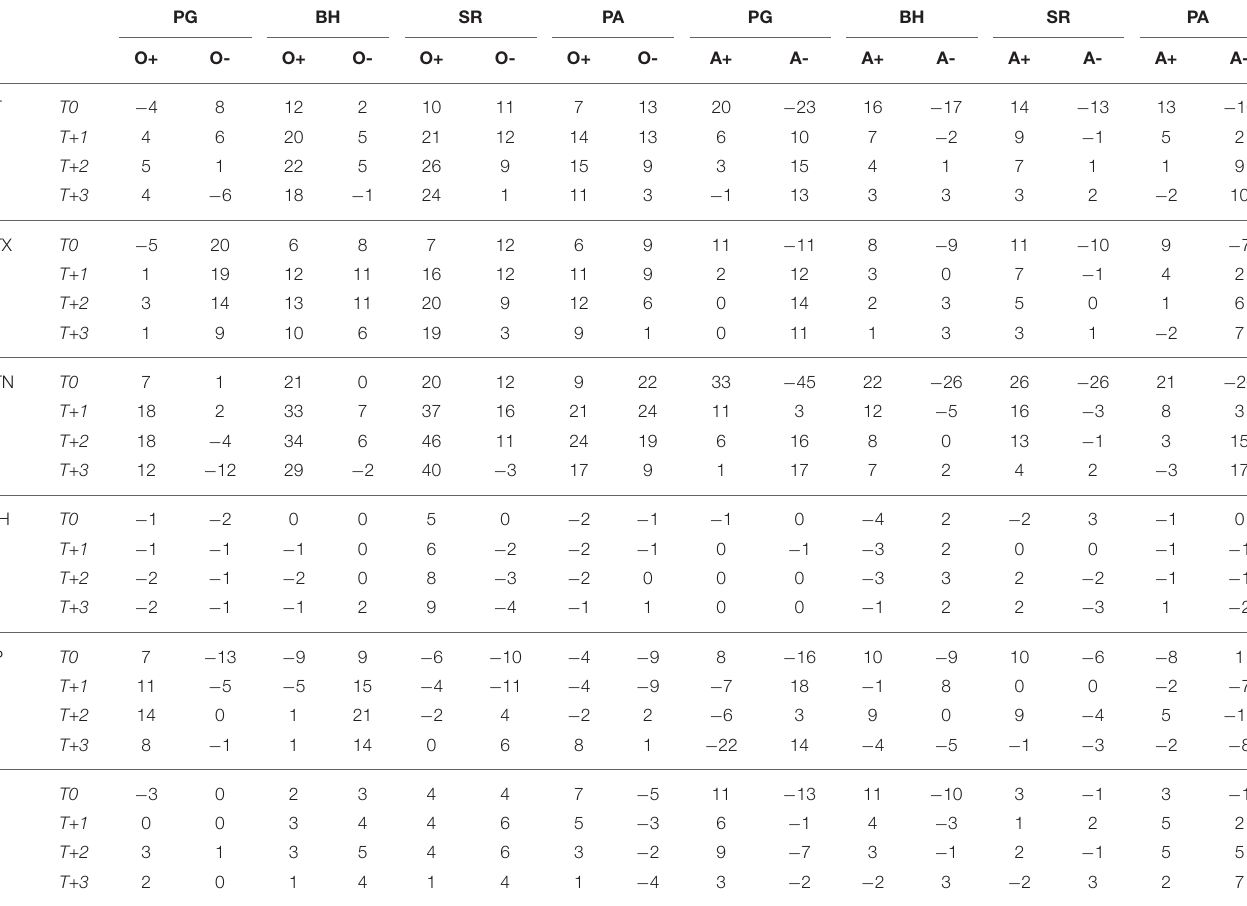
TABLE 8 | Deviations ( % ) of monthly mean (T), maximum (TX), and minimum (TN) air temperature, relative humidity (rH), precipitation (P) and wind speed (v) from the monthly means (2000-2016) during positive and negative ENSO and AAO phases.